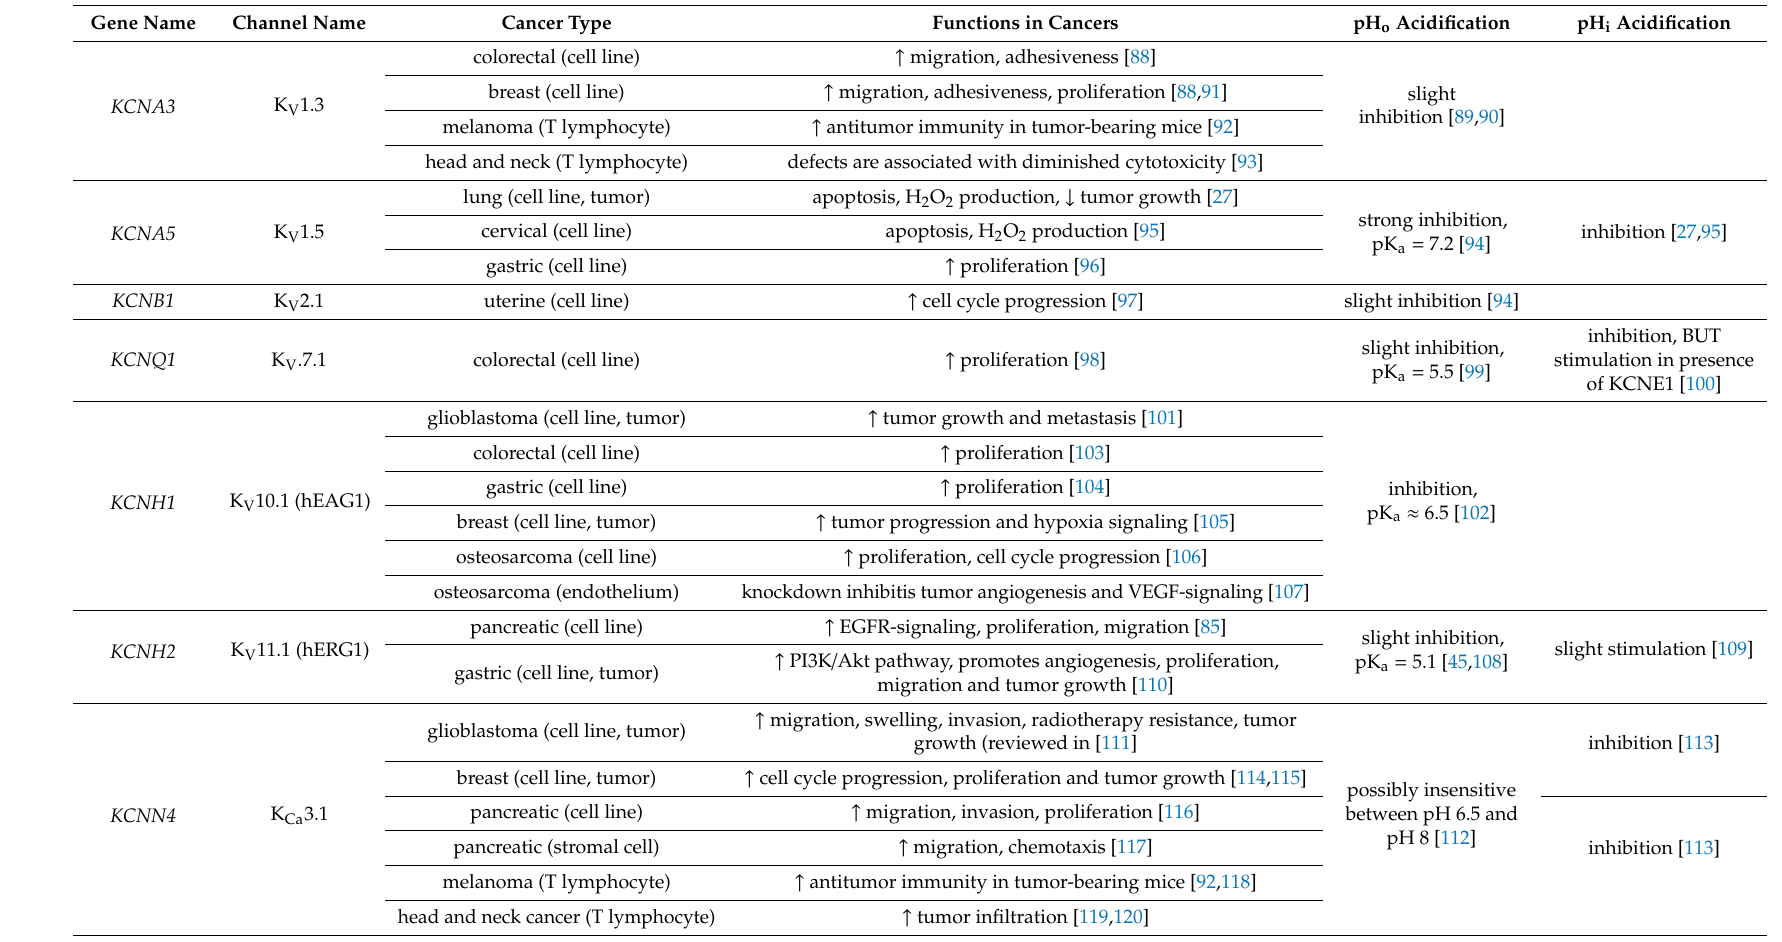
Table 1. pH-dependence of ion channels involved in